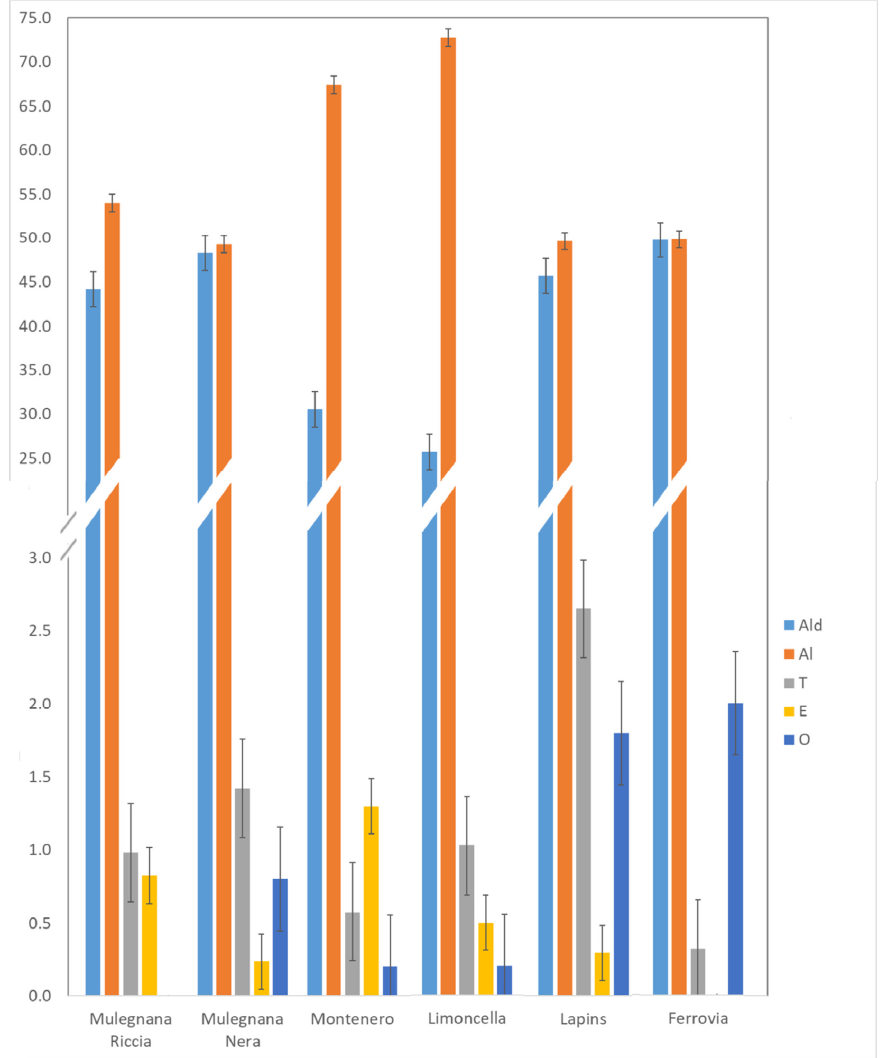
Figure 5. Distribution of the VOCs identified in each investigated sweet cherry genotype by chemical family (Mulegnana Riccia, Mulegnana Nera, Montenero and Limoncella, Lapins and Ferrovia). Ald: aldehydes; Al: alcohols; T: terpenes; E: esters; O: others.